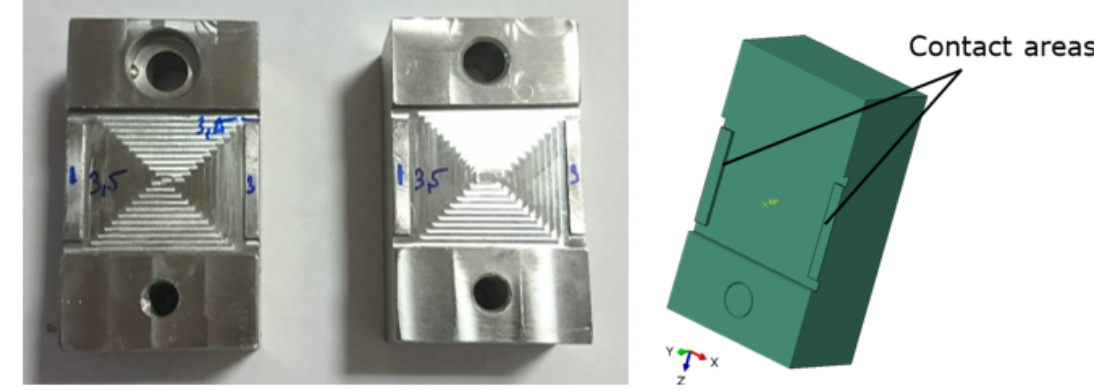
Figure 16. Example of physical plant geometry modification - the milled interior of the mass (one half). This milling has reduced the contact area to two narrow strips ( left and right ) to reduce uncertainty of the contact surface, resulting in better precision of higher bending modes